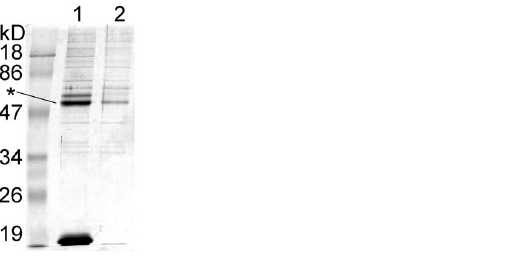
Figure 2. The binding of tubulin and calcineurin to the cytoplasmic loop of mouse TRESK is also reproduced in pull- down assays. Ni-NTA resin with immobilized TRESK-loop-His 8 ( lane 1 , see the bait protein below 19 kD) or without the bait ( lane 2 ) were used to pull down protein partners from mouse brain cytosol. Tubulin (indicated with an asterisk ) clearly interacted with the bait protein, although its nonspecific binding to the control resin was also non- negligible. The band of calcineurin A subunit is discernible above that of tubulin in lane 1 . (In this experiment, the nonspecific binding sites of the resin were not blocked with bovine serum albumin (BSA) and the cytosol was not depleted by preincubation with the chromatographic resin before the pull-down assay. These procedures were generally applied in further pull-down experiments, to reduce the nonspecific binding of proteins to the